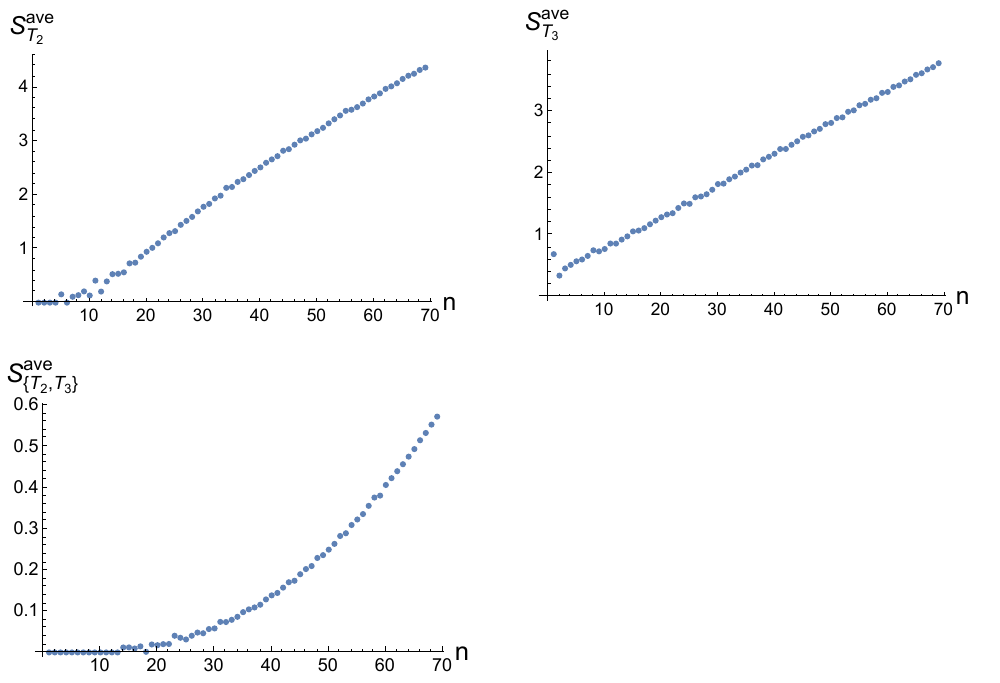
Figure 5 . Figures showing the average entropy values S ave